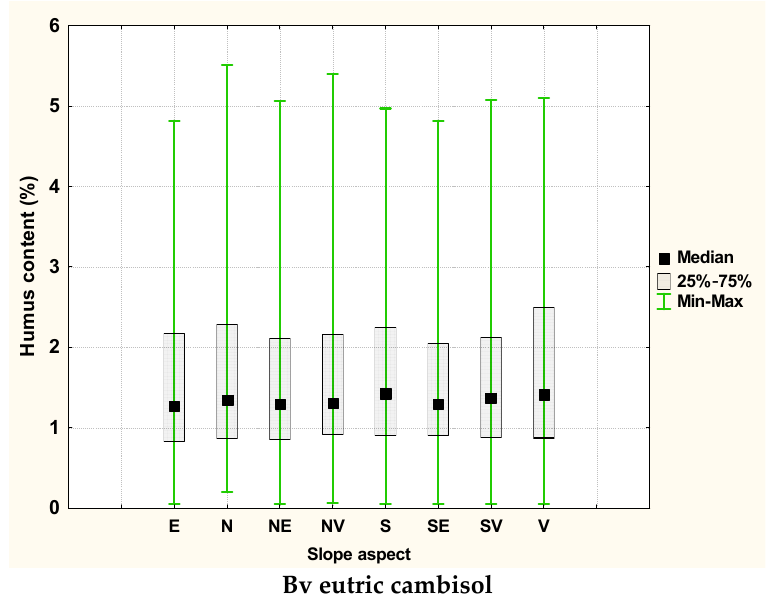
Figure 5. The variation of soil organic matter content in Bv horizon of eutric cambisol.